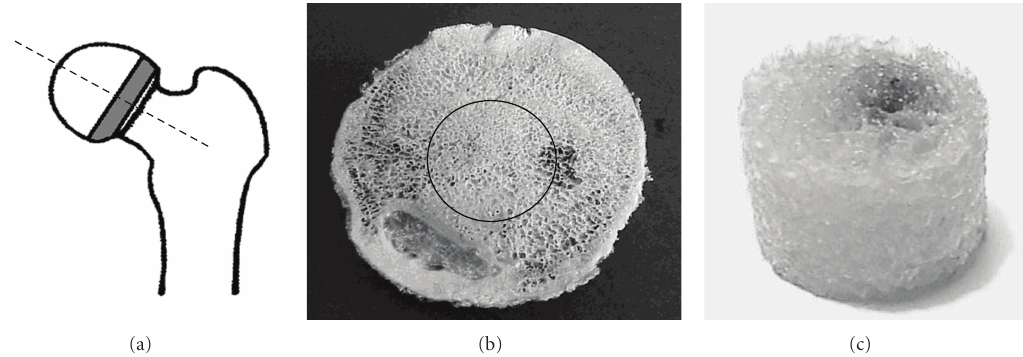
Figure 1: Method of obtaining sample: (a) cutting of slice; (b) cutting of sample; (c) final shape of